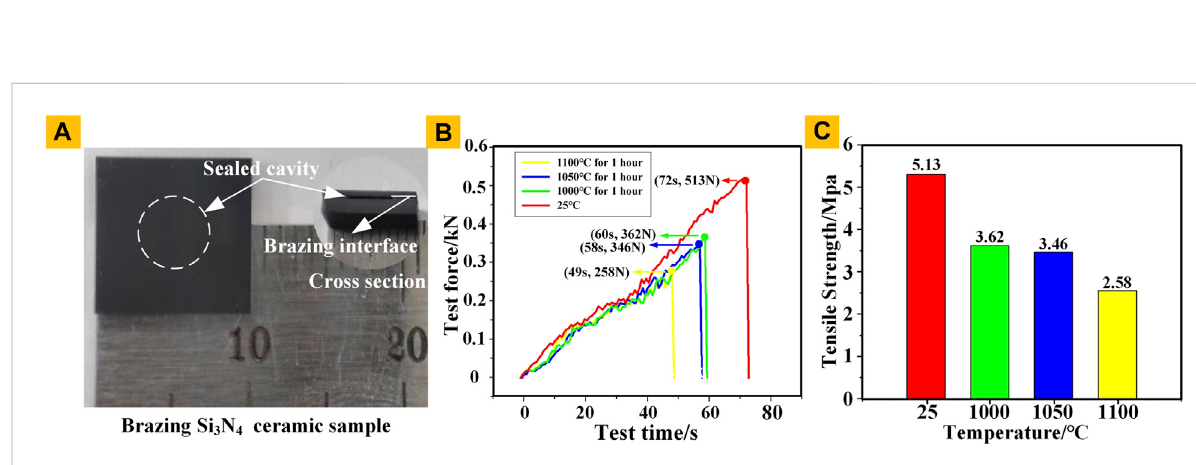
samples in a high temperature furnace at 1,000, 1,050, and 1,100 ° C for 1 h, then they were fi xed on the tensile machine with adhesive for tensile test, and fi nally they were pulled apart under the tensile force of 362, 346, and 258 N, respectively. The curves of test time and test force are illustrated in Figure 5B. The tensile strength tests after different temperature are 5.13, 3.62, 3.46, and 2.58 MPa, as presented in Figure 5C. These values exceed the joint strength required to fabricate some pressure